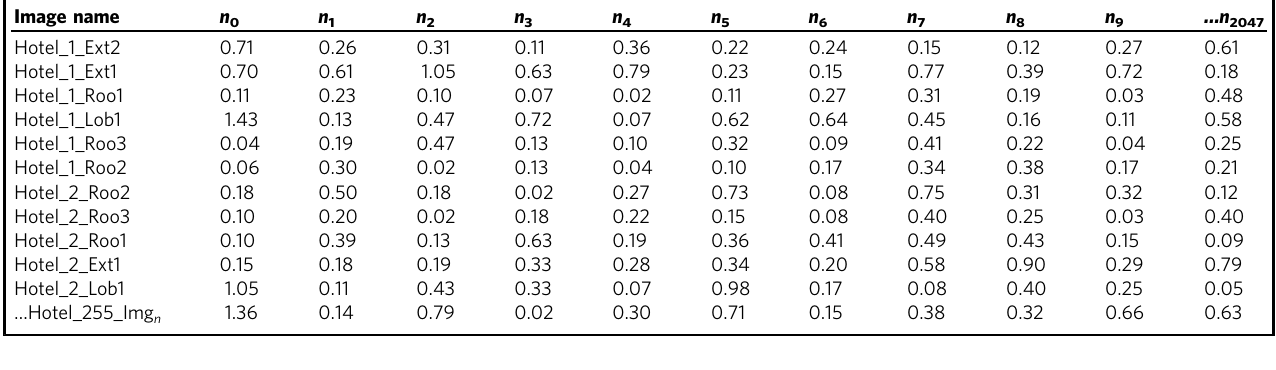
Table 2 Model fi t statistics. Model